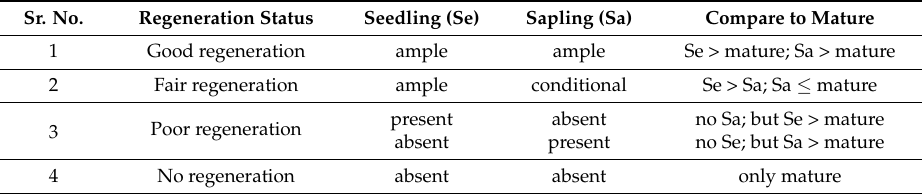
Table 2. Different regeneration statuses of a